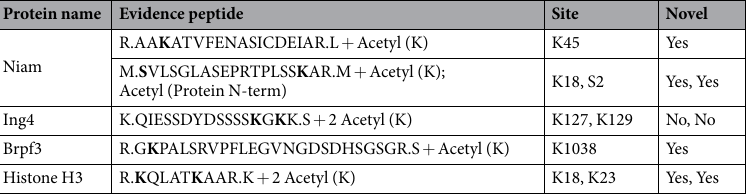
To dissect the list of proteins, GO terms were annotated using DAVID Bioinformatics Resources tool 36 (Supplementary Table S3). In the cellular compartment category, over 80% of genes were annotated with the term nucleus. More specifically, there was a strong enrichment in genes localised to nucleolus, consistent with the nucleolar localisation of Niam 28 . The terms ribosome and chromosome were also enriched, as were linked biological processes such as ribosome biogenesis, translation, DNA repair, and cellular response to DNA damage. This finding is in agreement with NIAM’s established role in proliferation 28, 29, 37 , its induction by DNA damage 37 , and the well described roles of NIAM’s partner, ARF, in ribosome biogenesis and translation (reviewed in 38 ). Chromatin remodelling and transcription were also enriched terms, possibly reflecting cellular roles associated to Niam’s interaction with the Myst2 HAT complex. As for molecular function, poly(A) RNA binding was the most enriched term, together with ribosome structural component, helicase activity and transcription factor binding. This suggests that Niam could be involved in various processes by means of interaction with distinct protein assemblies. In order to take a global view, we retrieved interactions between all Niam preys using STRING database 39 and displayed the resulting network (Fig. 4c). Clustering of the nodes revealed distinct molecular machines where several or all subunits had been identified as Niam preys. These included the INO80 complex, the ribosome, the RNA polymerase II complex, the B-WICH complex and the snoRNP complex amongst others. The high degree of previously described interactions between Niam preys provides additional support to their identification as bona fide binding partners. All these clusters are connected between them, reflecting the closeness of these machineries and the processes they are involved in. The INO80 complex is a chromatin remodelling complex involved in tran- scription, DNA replication and repair 40–42 . All reported subunits of this complex were identified with high protein scores, suggesting it interacts with Niam strongly and directly (Supplementary Table S2). Our results confirm the finding from a large scale human interactome study where INO80E was identified as a NIAM-interacting protein by yeast two-hybrid 43 . The B-WICH complex is a chromatin remodelling machine that is also involved in DNA replication in addition to rDNA transcription 44 . This is interesting in light of the role of Myst2 in replication 21, 22, 45 . Our data strongly suggest that Niam might also have roles in transcription, DNA replication and repair, cooper- ating with Myst2. A role for the Myst2 and Niam interaction network in development and disease. Myst2 is essential for mammalian development, its absence resulting in embryonic lethality 6 . NIAM functions as an anti-proliferative factor in somatic cells and is required for maintaining chromosomal stability, suggesting NIAM may act as a tumour suppressor 28, 29 . In support of that conclusion, NIAM expression is down-regulated by onco- genic miR-155 in B-cell lymphoma 46 and Niam-deficient mice develop spontaneous tumours, most notably B-cell lymphoma 37 . To date, a possible role for Niam in embryonic biology has not been investigated, although it was first identified as a TGF β -regulated gene in preimplantation mouse embryos, hence its original designa- tion as Tbrg1 47 . We therefore explored whether the Myst2-Niam network is generally involved in embryonic development. The MGI database contained annotations for 59 out of 118 input genes (Supplementary Table S4). Loss-of-function abnormal phenotypes were reported for 56 proteins (47% of the network, 56/118). 68% (38/56) showed embryonic phenotypes, with 64% (36/56) resulting in embryonic lethality (Fig. 5a,b). In addition, 64% (36/56) displayed abnormal development phenotypes. Based on those findings we carefully monitored litter sizes in Niam-deficient mice versus wild-type counterparts. As shown in Fig. 5c, Niam − / − females bred to Niam − / − male mice had significantly smaller litter sizes (average of 3.8 pups per litter) compared to wild-type mouse breedings (average of 6.1 pups per litter). Notably, embryos isolated from Niam − / − mice at embryonic day 13.5 displayed greater incidence of embryonic lethality and other developmental abnormalities, such as increased size, compared to wild-type embryos (Fig. 5d). These results strongly suggest that the Myst2-Niam protein interaction network is vital in early stages of development in the mouse. MYST2 has been linked to cancer by way of its role in replication and also through is interaction with the androgen receptor and tumour suppressors ING4 and ING5 1 . Some studies point to MYST2 being an onco- gene, since its overexpression enhances the transformed phenotype of cancer cells 48 . Furthermore, MYST2 is overexpressed in several cancer tissues 49 . In contrast, NIAM mRNA and protein expression are markedly down-regulated in numerous cancers and Niam mutant mice expressing low levels of the protein develop spon- taneous tumours 28, 37, 46 . Given the involvement of both proteins in cancer, we asked whether human orthologues of the Myst2-Niam network are responsible for the development of cancer. We queried the Cancer Gene Census database and found that somatic mutations in eight human orthologues of Niam-Myst2 network proteins are causally linked to cancer (Supplementary Table S5). We also investigated their involvement in hereditary diseases